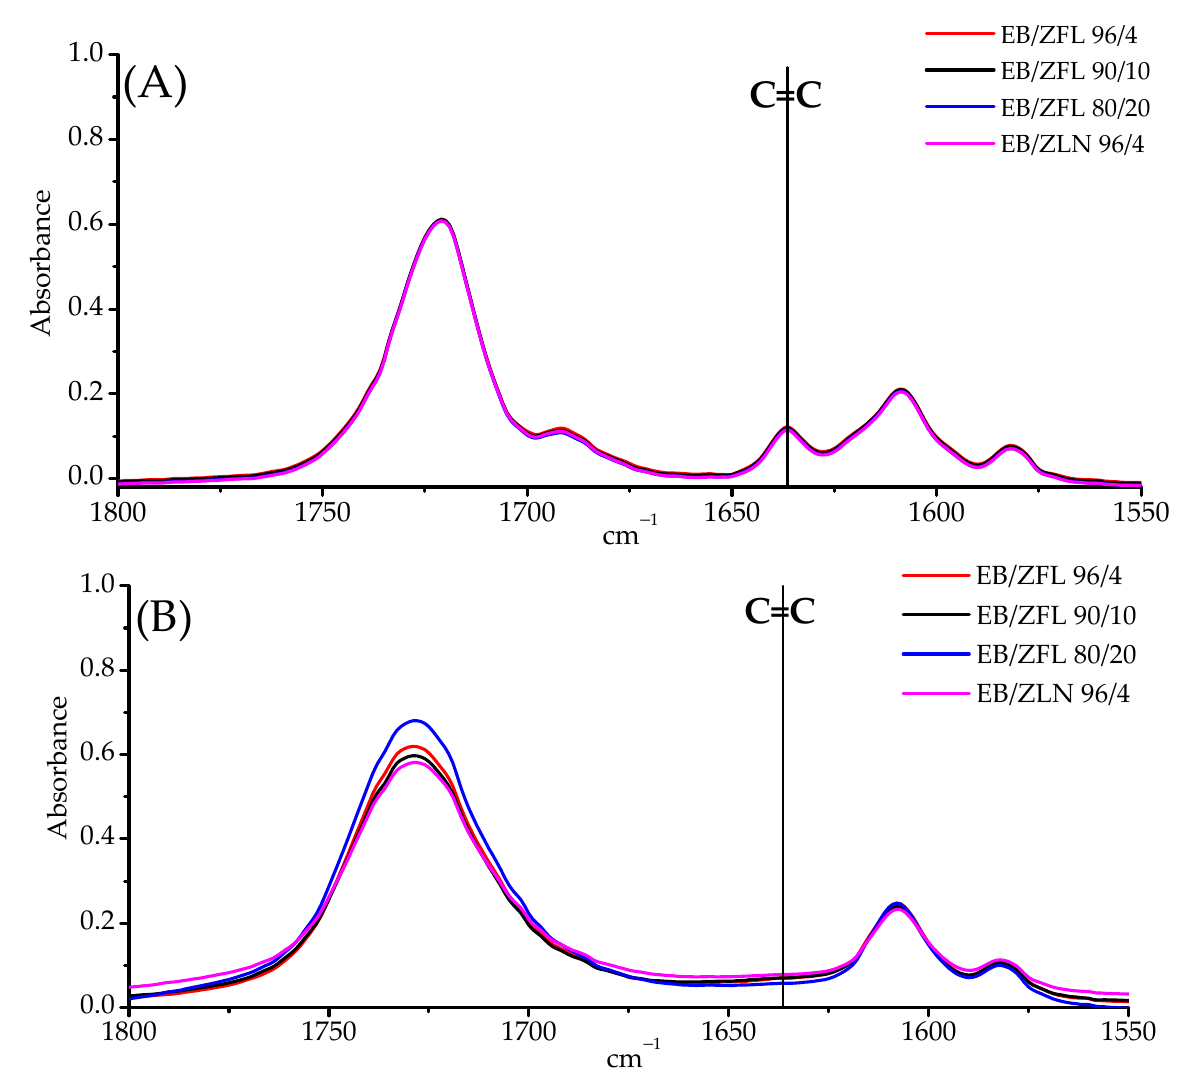
Figure 7. FTIR-ATR spectra of EB-ZnO composites, before ( A ) and after ( B ) exposure to UV radiation. The absence of the band at about 1635 cm − 1 after exposure to UV radiation is a clear indication of the completeness of the UV curing process.